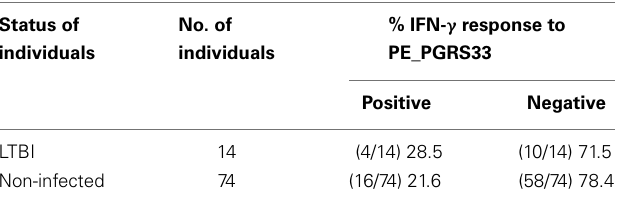
Table 1 | IFN- γ release assay to detect responders to the PE_PGRS33 complete protein in LTBI and non-infected individuals .